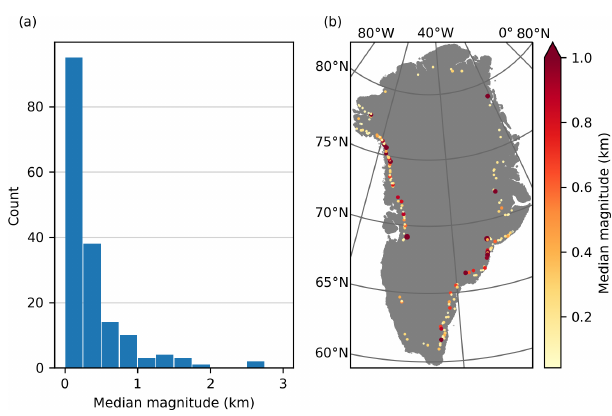
Figure 4. (a) Histogram and (b) map of the distribution of the me- dian magnitude of terminus-position seasonality for all seasonally varying glaciers in the study. In panel (b) both the color and size of the points represent the magnitude of terminus-position